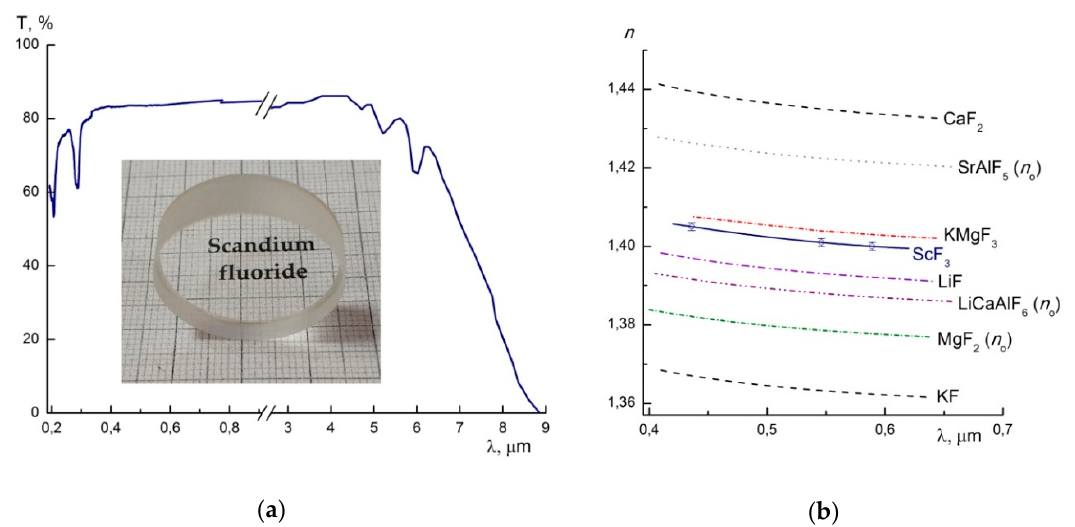
Figure 5. ( a ) Transmission spectrum of 3 mm thick crystal and fabricated ScF 3 optical element; ( b ) Refractive index dispersions of some fluoride crystals.